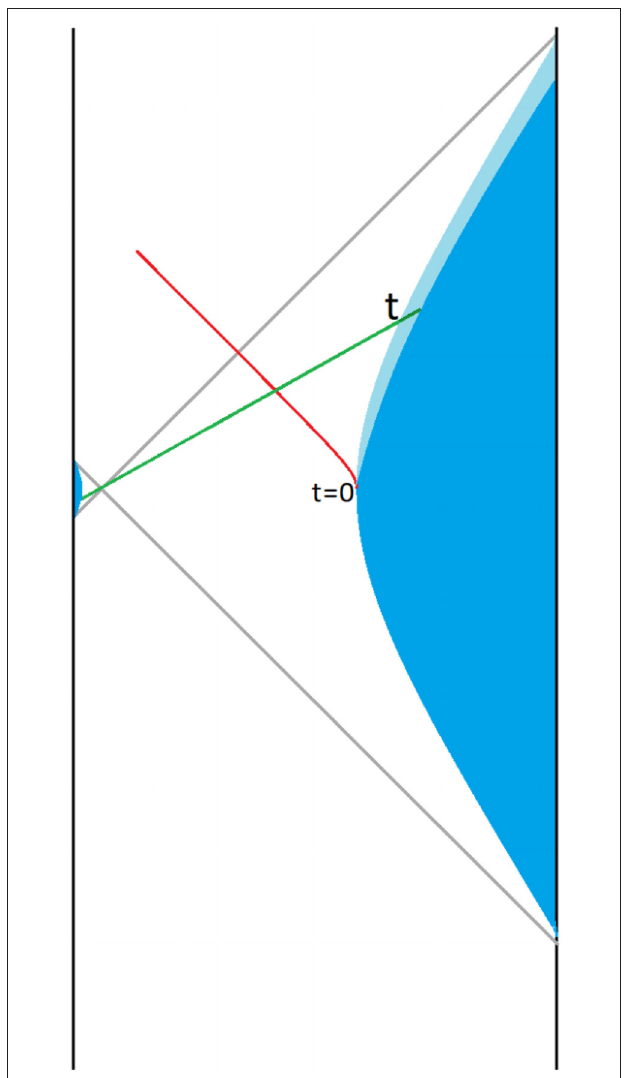
FIGURE 11 | The gauge fixed Penrose diagram with the right boundary intersecting the t = 0 surface at a fixed location half way between boundaries. The red curve is the world line of a particle dropped at t = 0 from the right boundary. The green surface is boosted from the t = 0 surface. The boost time t is the time variable that corresponds to the earlier